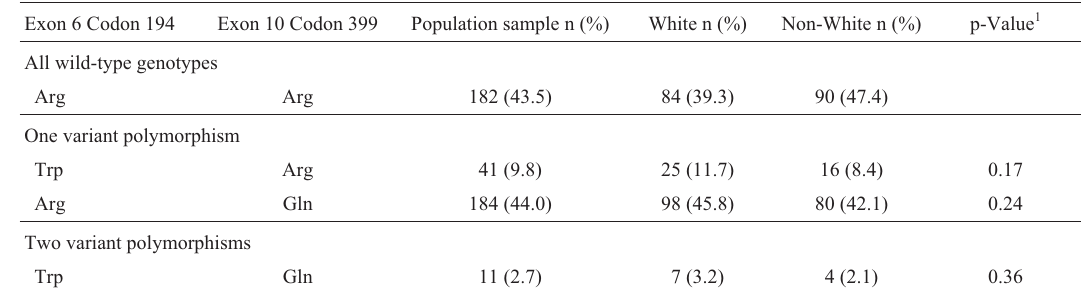
Table 3 - Intragenic association of the XRCC1 polymorphisms (Population